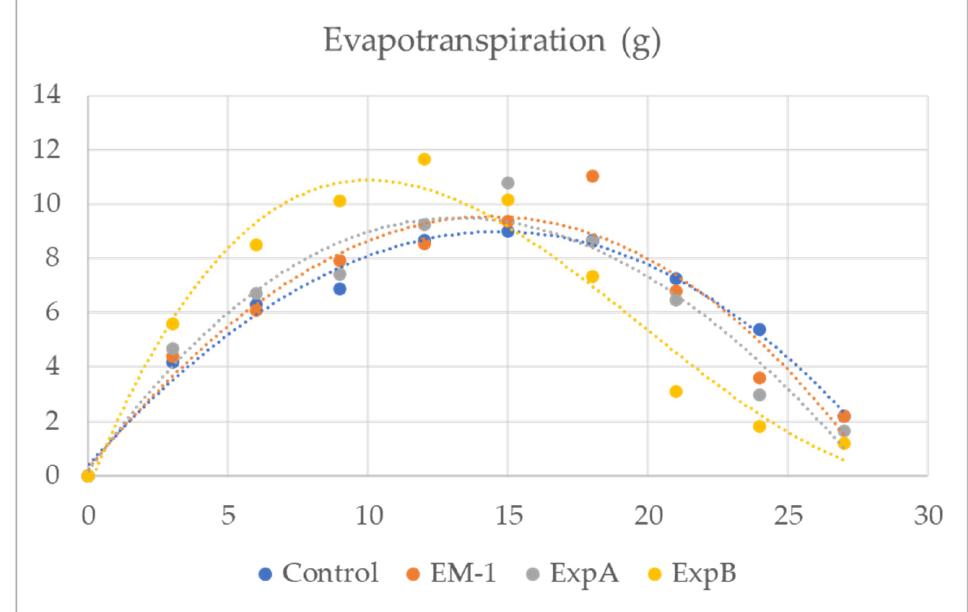
Figure 2. Evapotranspiration (g) of creeping bentgrass from 3 to 30 days after full hydration for grass mats treated with the untreated control, EM ‐ 1, ExpA and ExpB.